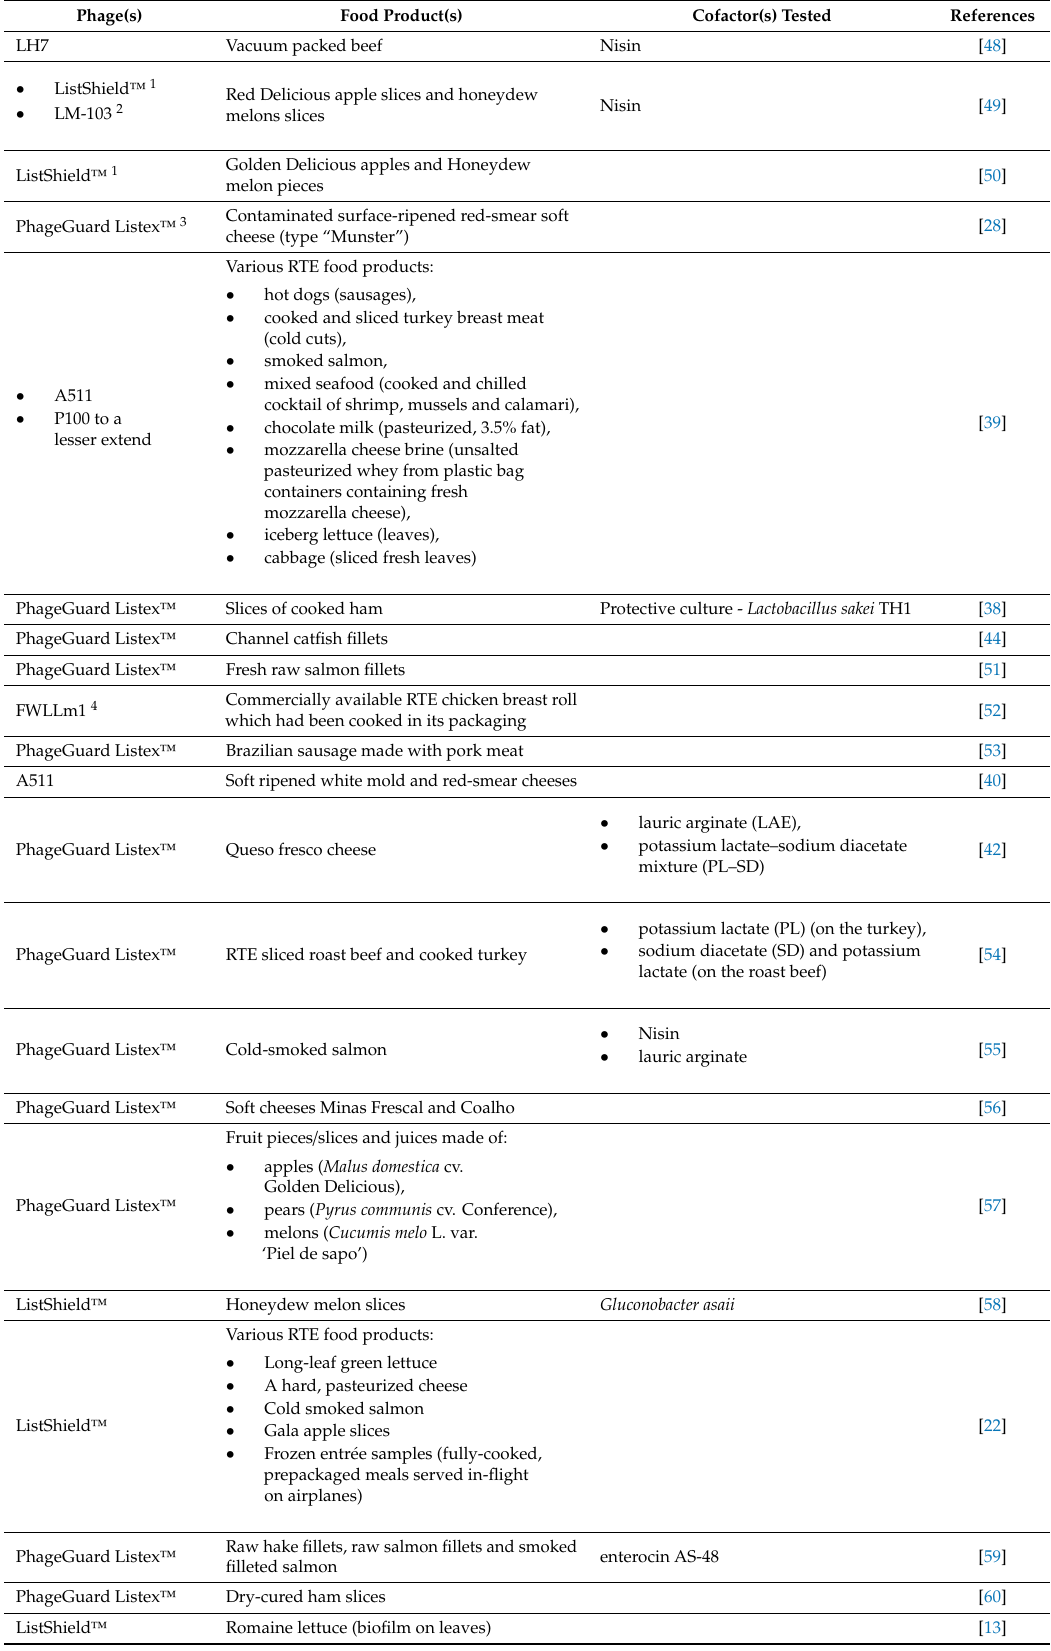
Table 1. Summarized attempts of phage-based Listeria monocytogenes inhibition in food products.